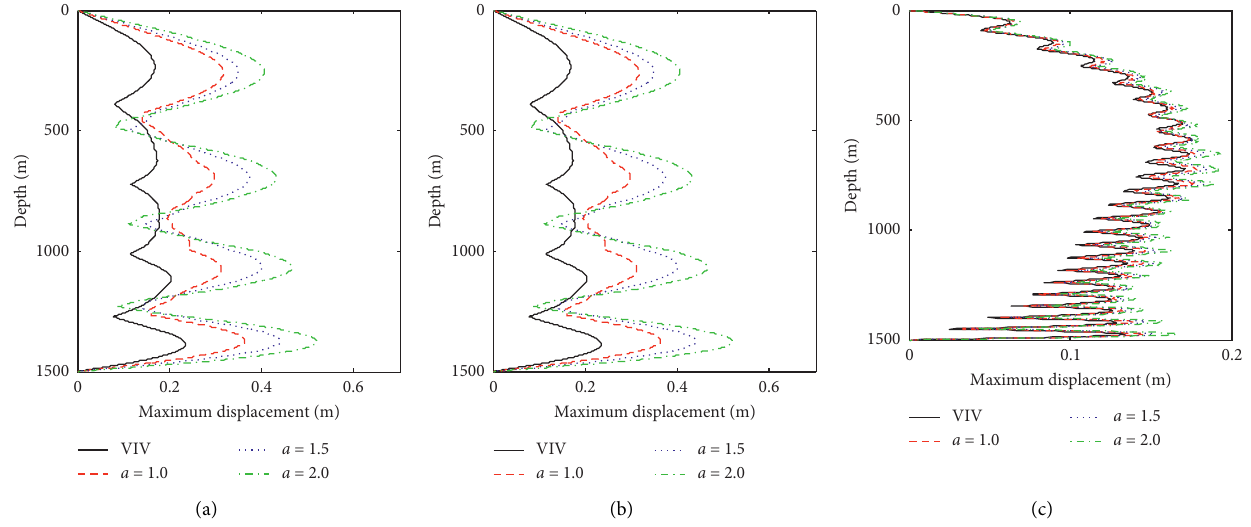
Figure 6: The maximum displacement of TTR ( Ω � 2 ω